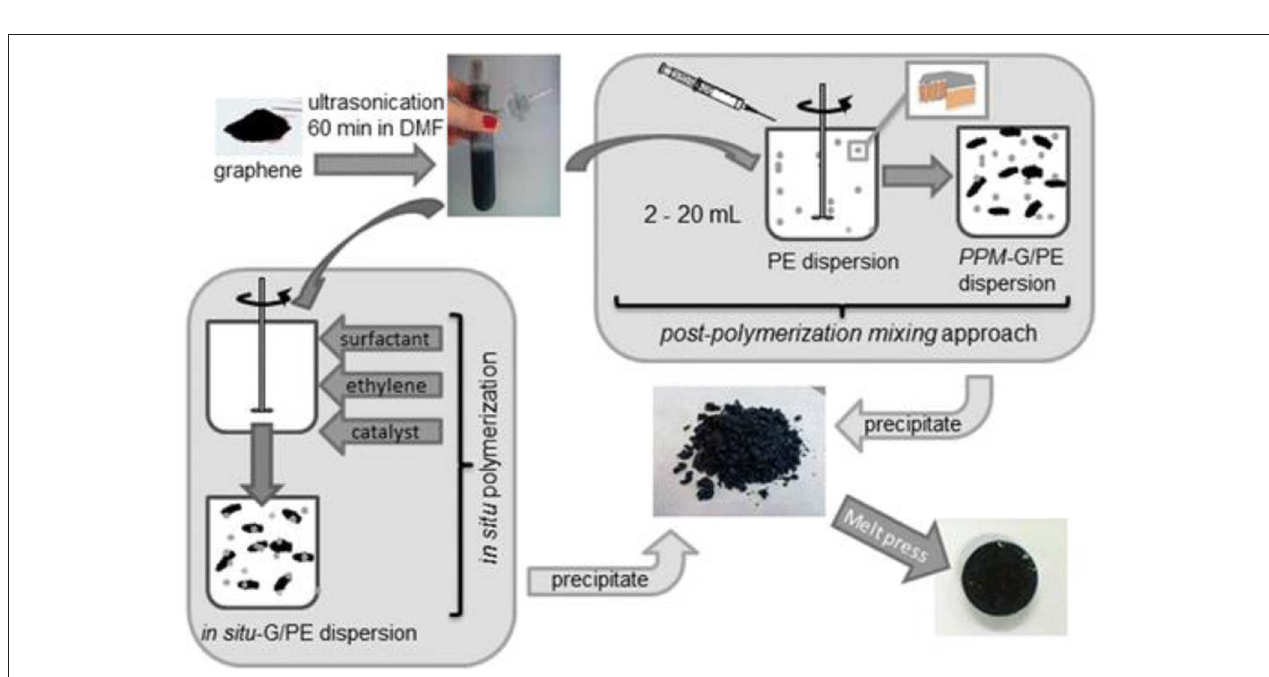
FIGURE 8 | (a) After 72h of ultrasonic exfoliation, carbon filler/tetrahydrofuran suspension were CNT, CNT:GNP with 0.1 mg/ml of filler concentration as shown in the images, with the diagrams of sediment fillers in various filler suspensions. (b,c) CNT/epoxy composite SEM diagrams. (d,e) GNP/epoxy composite SEM diagrams. (f,g) CNT:GNP SEM, scanning electron microscopy.